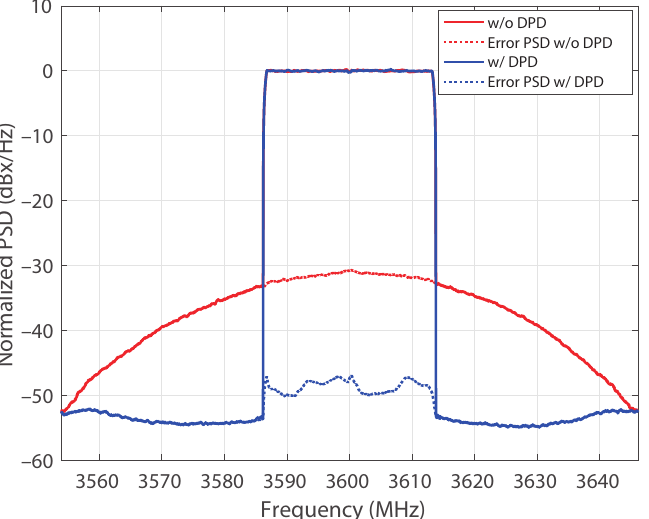
Figure 12. Output spectra without and with DPD. Average output level: 30